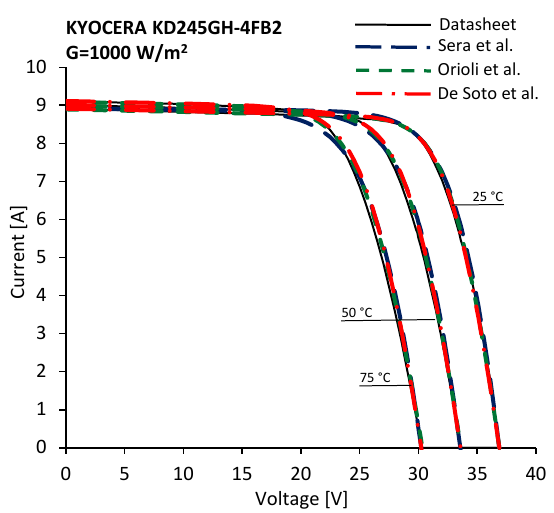
Figure 10. Comparison between the issued I-V characteristics of Kyocera KD245GH-4FB2 at G = 1000 W/m 2 and the characteristics calculated by means of the Sera et al ., the Orioli et al . and the De Soto et al . models.